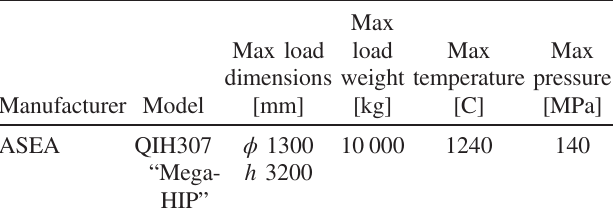
TABLE IV. HIP unit characteristics.